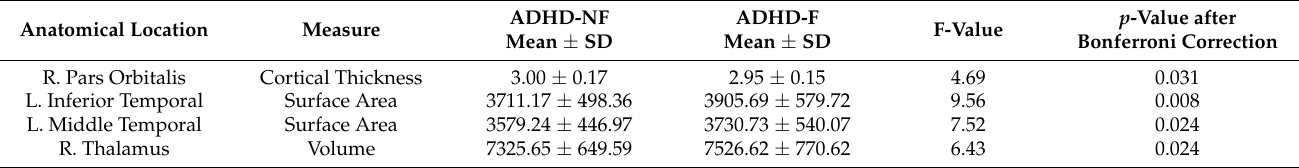
Table 3. Gray matter neuroimaging measures that show significant differences between Familial and Non-Familial groups with age, sex, and ETIV (for volume and area) as